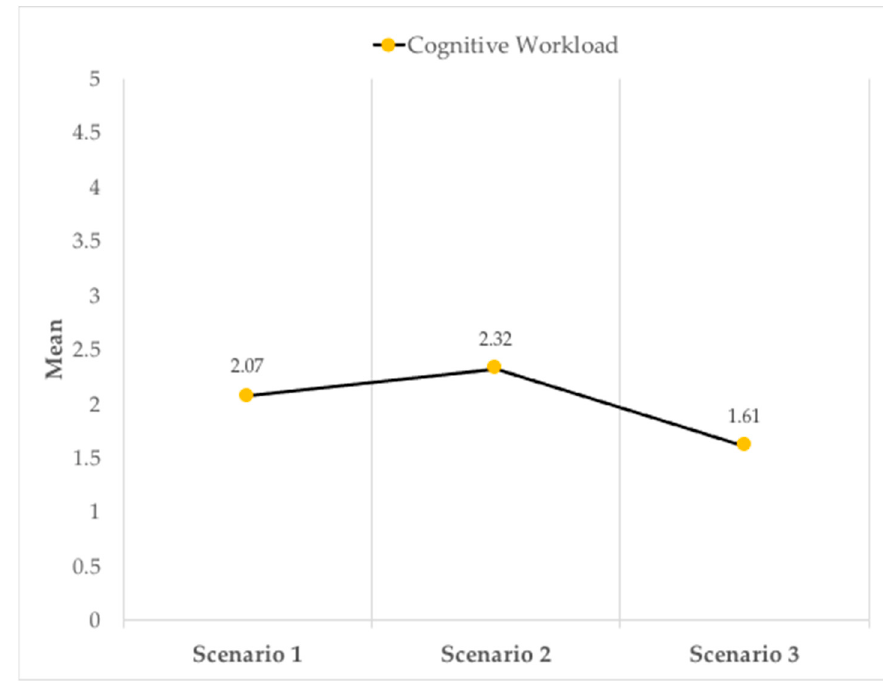
Figure 3. Friedman’s test mean ranks of cognitive workload across the three trials.